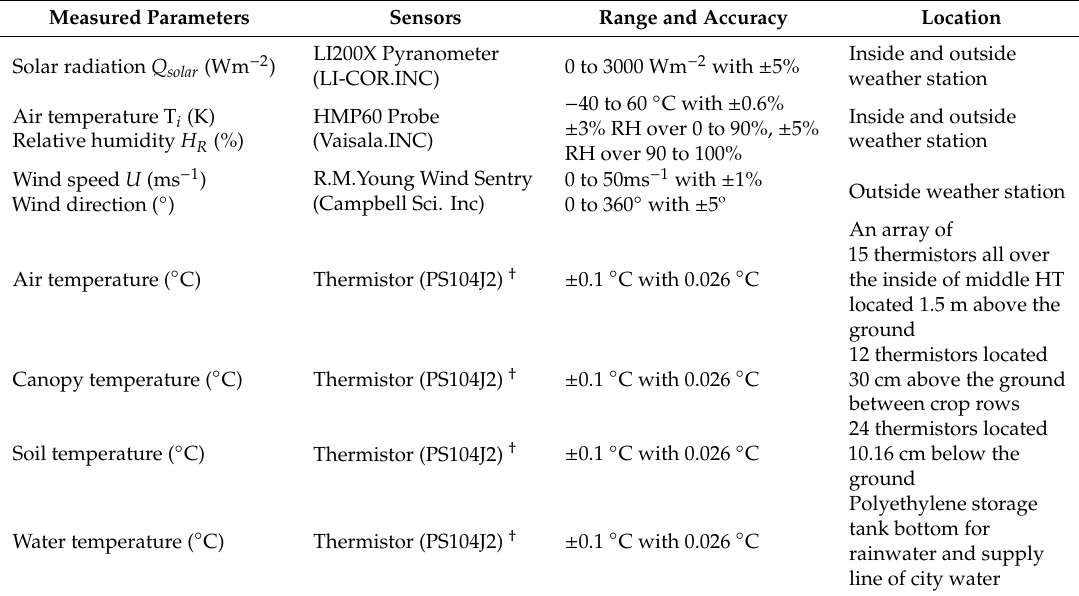
Table 1. Environmental parameters measured during the experiments